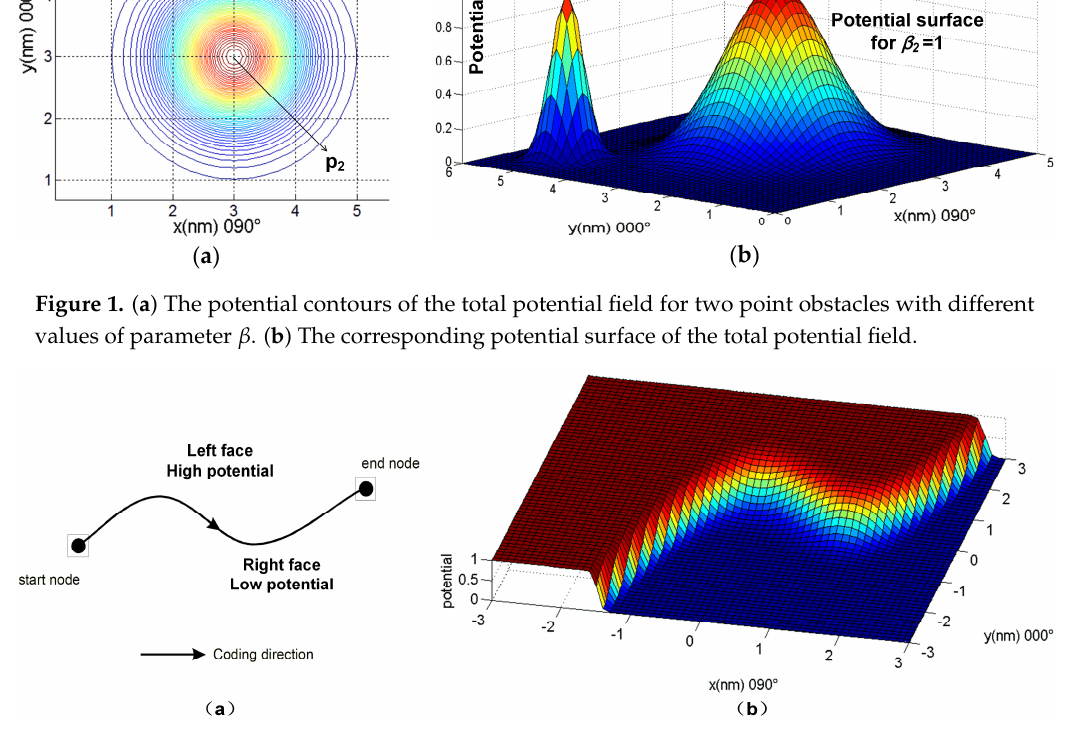
Figure 2. ( a ) The potential features for a curve with the coding direction. ( b ) The surface of a potential field for a curve-shaped obstacle.